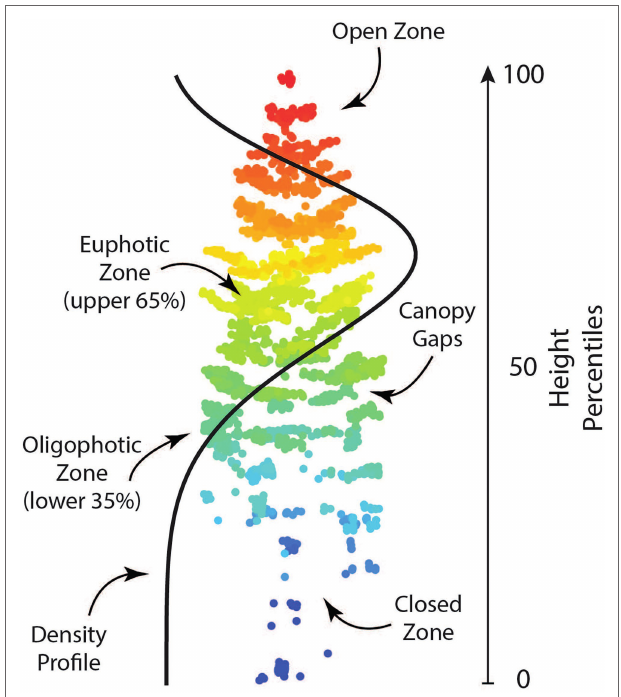
FIGURE 2 | A single tree point cloud with example ALS-derived traits. These metrics provide information regarding the vertical canopy structure of a tree and how it can vary between